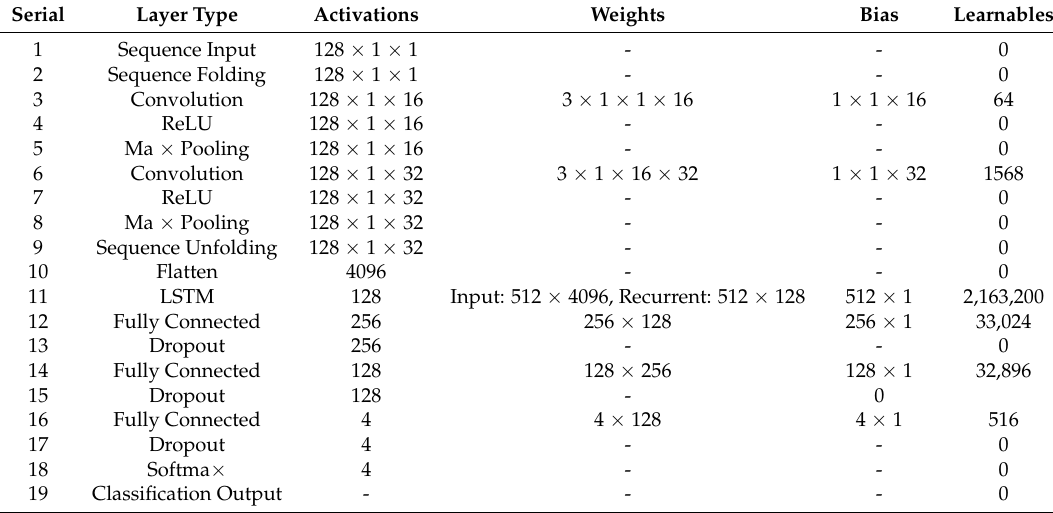
Table 2. Details of 1D-CNN + LSTM Architecture.